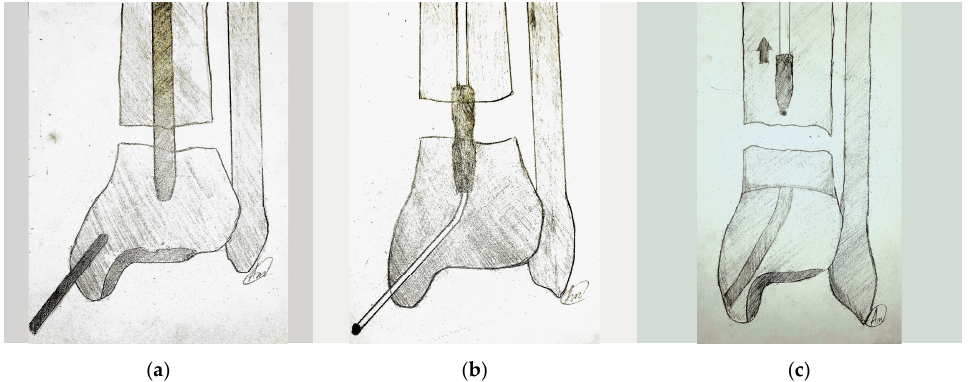
Figure 17. Retrograde 3 mm ball-tipped guide wire through the opening in the medial malleolus. ( a ) Fenestration of the medial malleolus. ( b ) Pushing the wire through the tibial canal until it exits. ( c ) Pulling out of the broken